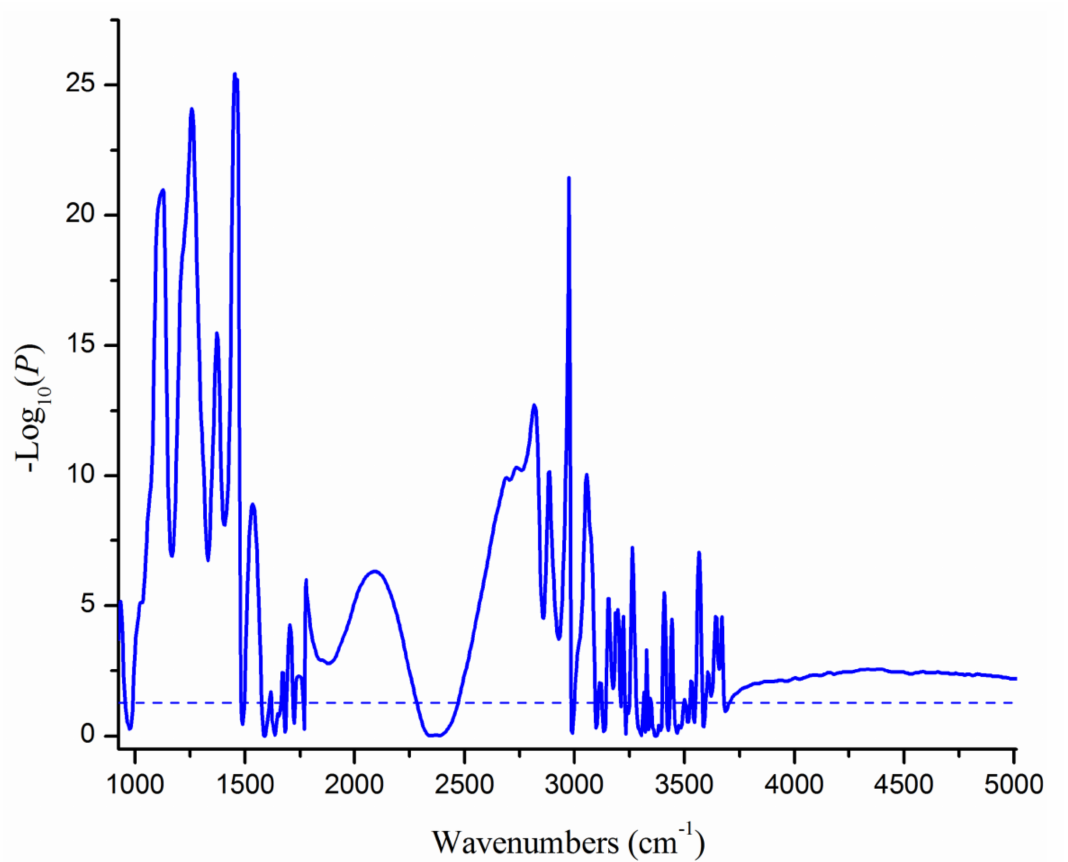
Figure 3. The significance of the effect of the days in relation to estrus on milk infrared wavenumbers. The horizontal line indicates a threshold at − log 10 ( p ) of